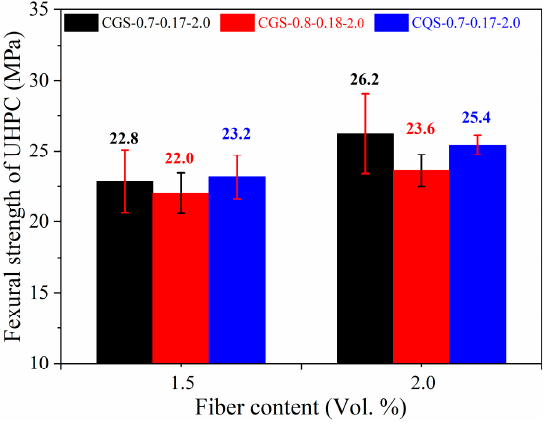
Figure 9. The flexural strength of the UHPC.